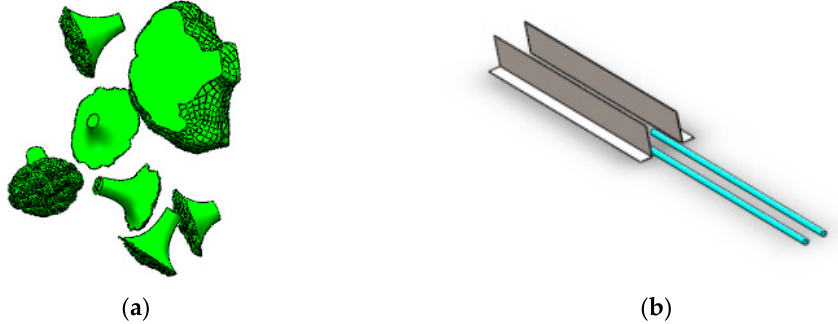
Figure 6. Schematic diagram of the two simulation situations: crossed small blocks on the left; stacked between large and small blocks on the right. First, fix a circular belt speed of 300 mm/s, and set another circular belt speed of 400 mm/s, 500 mm/s, and 600 mm/s in turn (because the initial speed of the block is 300 mm/s, the speed of the other circular belt should not be set too high to avoid damage to the blocks). Shown in Figure 7 for the small block staggered screening simulation analysis charts, respectively, are the trajectory of two blocks and the distance and staggering time of the center of mass of the two blocks moving in the direction of gravity.